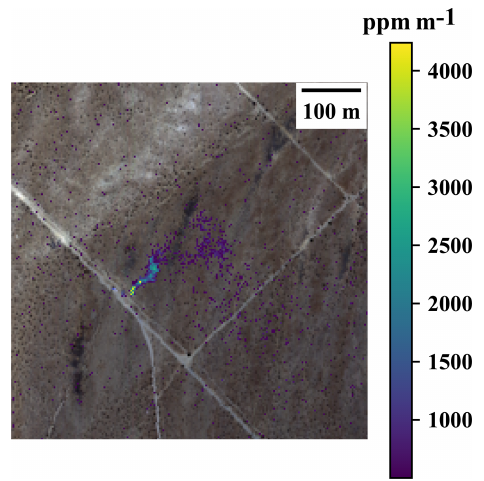
Figure 14. An observed AVIRIS-NG scene in a controlled-release experiment from a natural gas pipeline located at Victorville, CA (34.8 ◦ , − 117 . 3 ◦ ), on 11 October 2017 with the flux rate of 89 ± 4kgh − 1 .